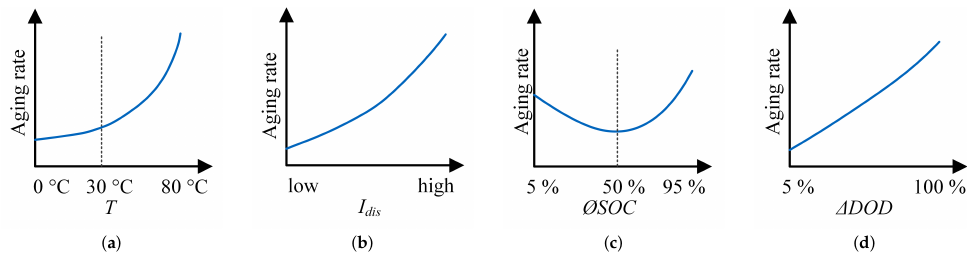
Figure 3. Assumed qualitative dependencies of aging rate on stress factors ( a ) T , ( b ) I dis , ( c ) ∅ SOC , and ( d ) ∆ DOD , according to [3,5,37].